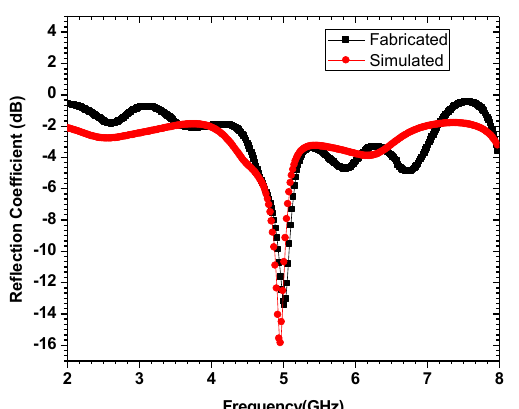
Figure 14: Comparison of S11 of simulated and fabricated